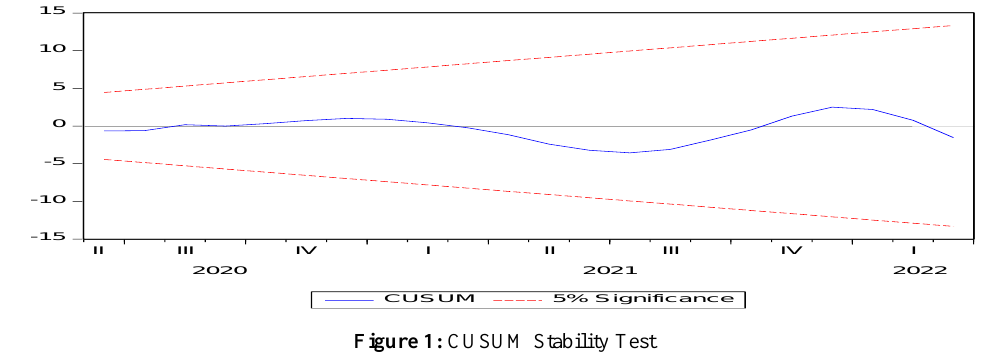
Figure 1: CUSUM Stability